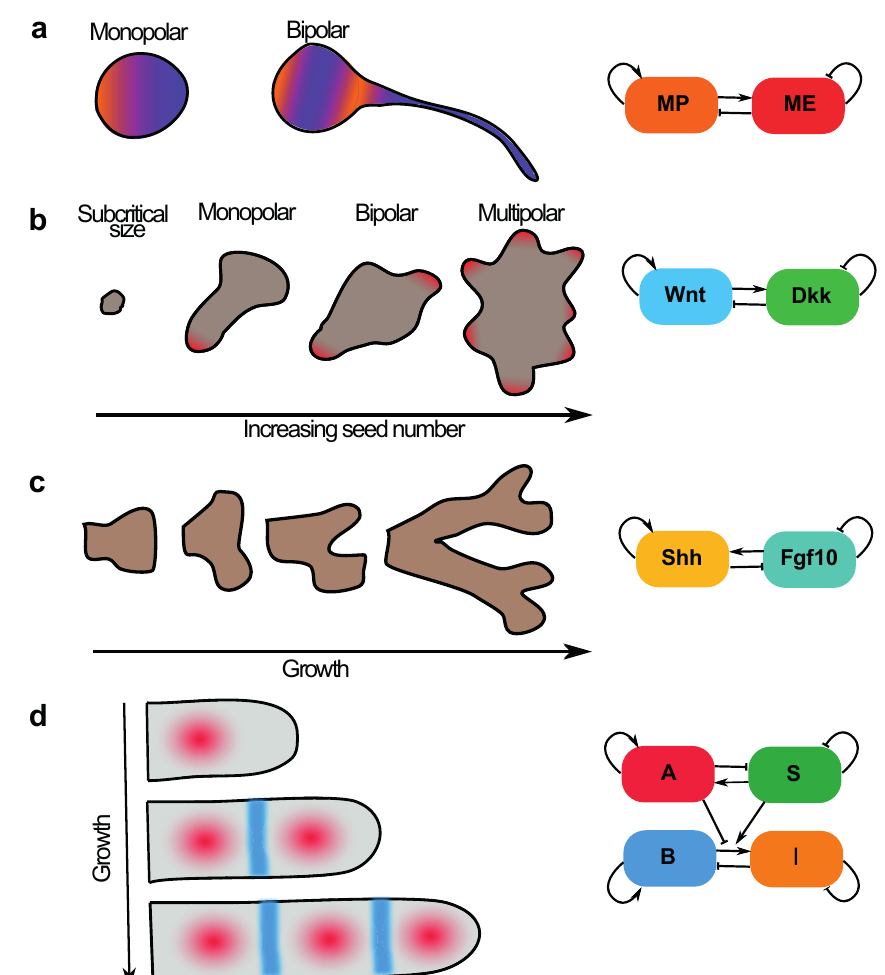
Figure 4. Sequential pattern formation in developmental systems. ( a ) In in vitro cultured neurones, polarity arises sequentially. A second polarity axis is formed after cell growth, and its orientation is “mirrored” off the first. A putative symmetry breaking circuit is presented adjacently [69], considering a membrane-protein (MP) activator coupled to modulators of endocytosis (ME), representing the effects of small GTPases. ( b ) Gastruloids polarise and elongate only when initialised with a critical number of cells [70]. For seed numbers beyond this initial bifurcation value, gastruloids can self-organise more axes. T/Brachyury expression is localised to the protrusion in monopolarised gastruloids, and is speculated to also be localised to further protrusions in multipolar variants. A potential feedback circuit is drawn adjacently, which remains to be investigated. ( c ) An activator–substrate model for lung branching [25], based on autocatalytic production of the signalling molecule Shh (activator) at the lung bud tip, via consumption of the substrate molecule Fgf10. ( d ) A dot-stripe mechanism is proposed to pattern the joints of developing digits: a Turing-like dot-forming system specifies the positions of bones and orients through repression a Turing-like stripe-forming system to specify joints.